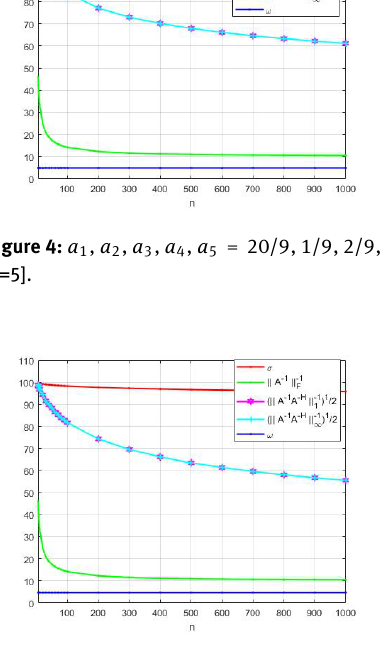
Figure 5: a 1 , a 2 , a 3 , a 4 , a 5 , a 6 = 2, 1/2, 2/3, 1, 1/3, 1/3 [i=6].